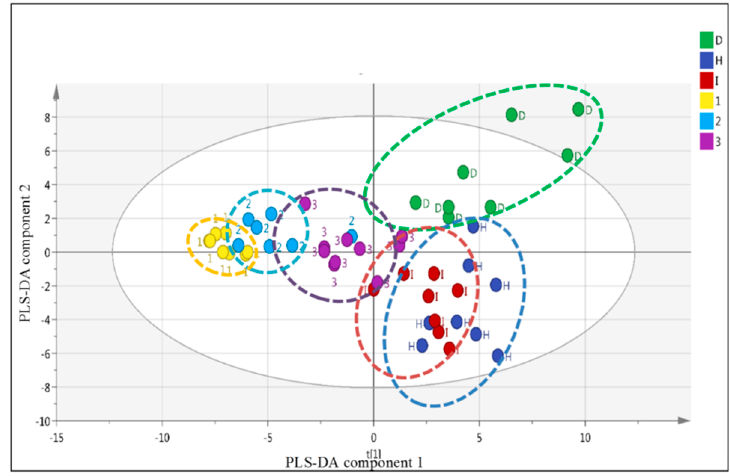
Figure 10. The score scatter plot from the PLS-DA of the healthy group (H), diabetes group (D), insulin-treated group (I), and the plant extract treated groups with the dose of 1 (1), 2 (2), and 3 mg / kg (3) at 24 h after the treatments, and 48 h after the alloxan injection.